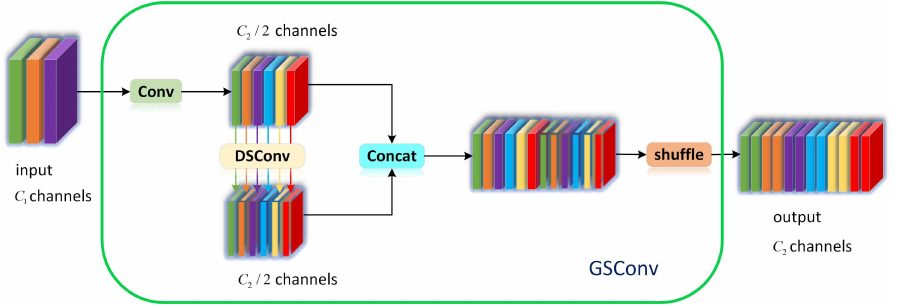
Figure 4. GSConv module structure.